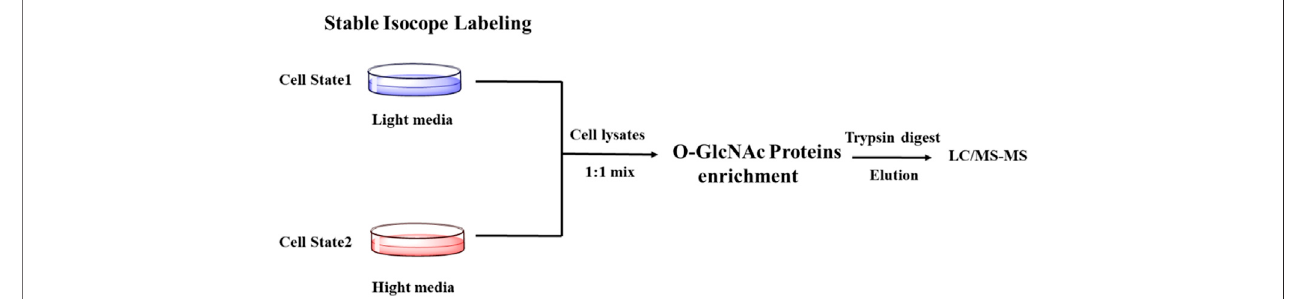
FIGURE 4 | Schematic of SILAC-based Quantitative proteomics for pro fi ling O-GlcNAcylation.